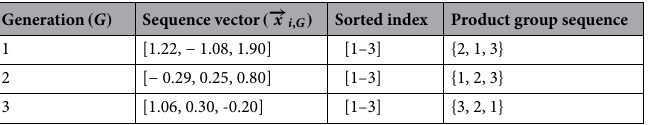
Table 3. Conversion of a sequence vector to a product group sequence using smallest position value